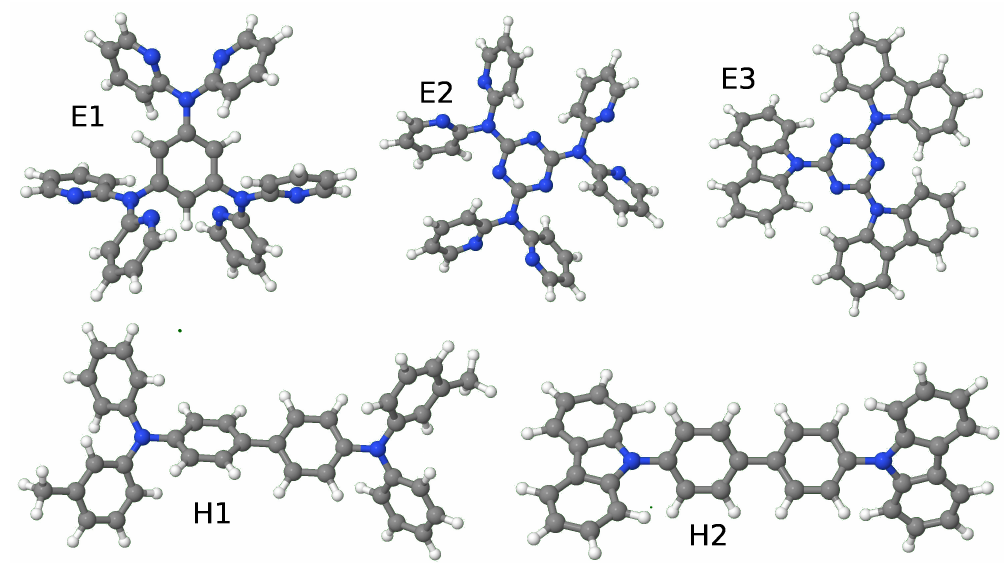
Figure 1. Schematic representation of the systems here studied, three electron-acceptors: 1,3,5-tris(phenyl-2-pyridylamino)benzene (E1) 2,4,6-tris[di(2-pyridyl)-amino]-1,3,5-triazine (E2) and 2,4,6-tris(carbazolo)-1,3,5-triazine (E3) plus two hole-acceptors: N,N (cid:48) -Bis(3-methylphenyl)-N,N (cid:48) -diphenylbenzidine (H1) and 4,4’-di(N-carbazolyl)biphenyl